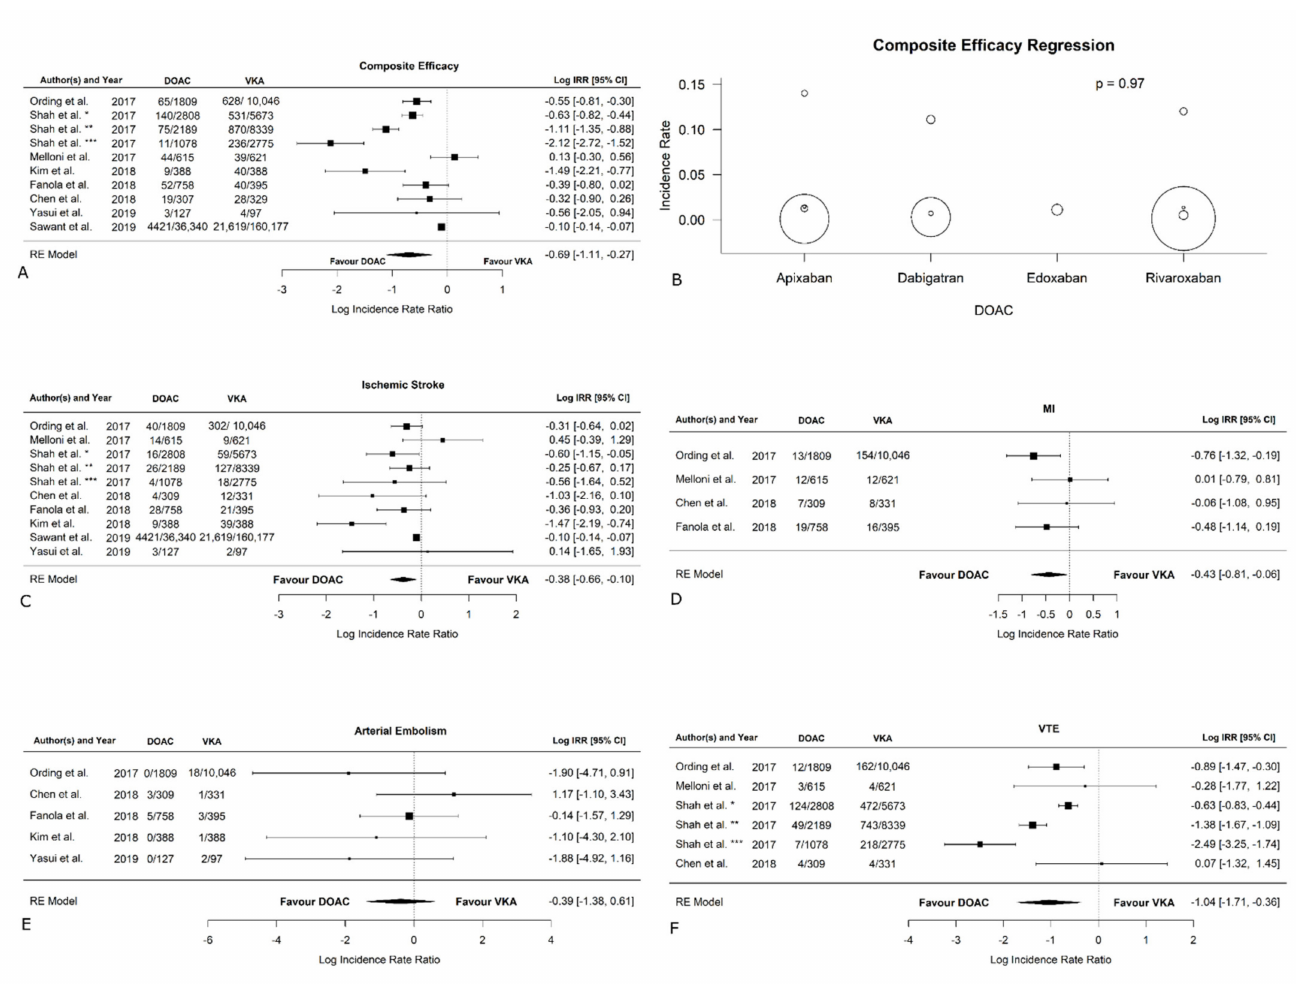
Figure 3. Efficacy outcomes in VKAs versus DOACs. ( A ). Composite efficacy ( B ). Composite efficacy regression. ( C ). Ischemic stroke. ( D ). Myocardial infarction. ( E ). Arterial embolism ( F ). Venous thromboembolic events. * rivaroxaban, ** dabigatran, *** apixaban